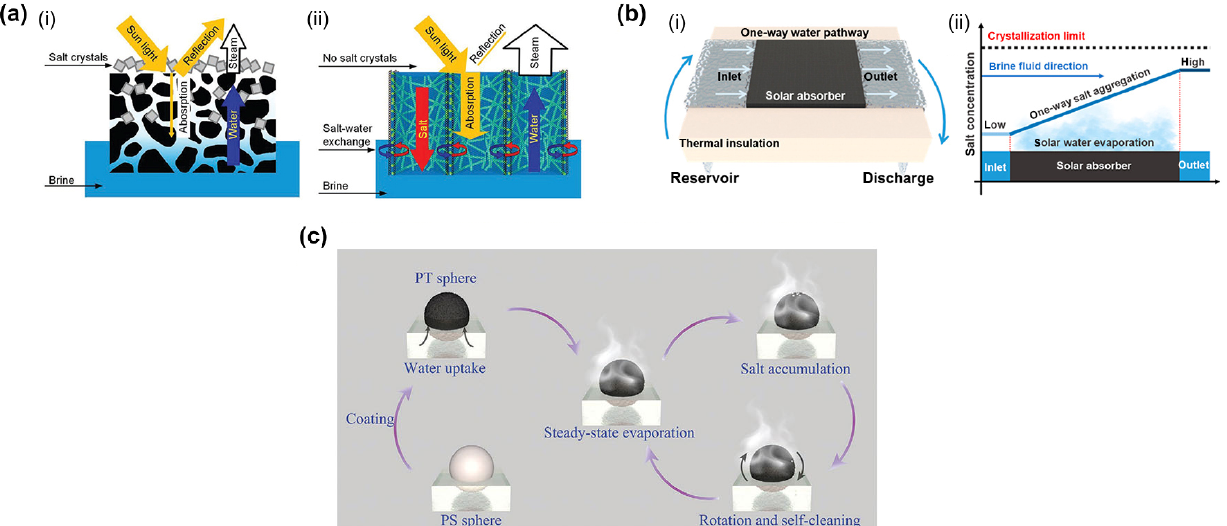
Figure 8 (a) The vertically arranged channels for salt rejection. Reproduced with permission from Ref. [127], © WILEY-VCH Verlag GmbH & Co. KGaA, Weinheim 2020. (b) Control bulk water flow for salt rejection. Reproduced with permission from Ref. [19], © American Chemical Society 2020. (c) A spherical photothermal body rolls intermittently for salt rejection. Reproduced with permission from Ref. [136], © Wiley-VCH GmbH